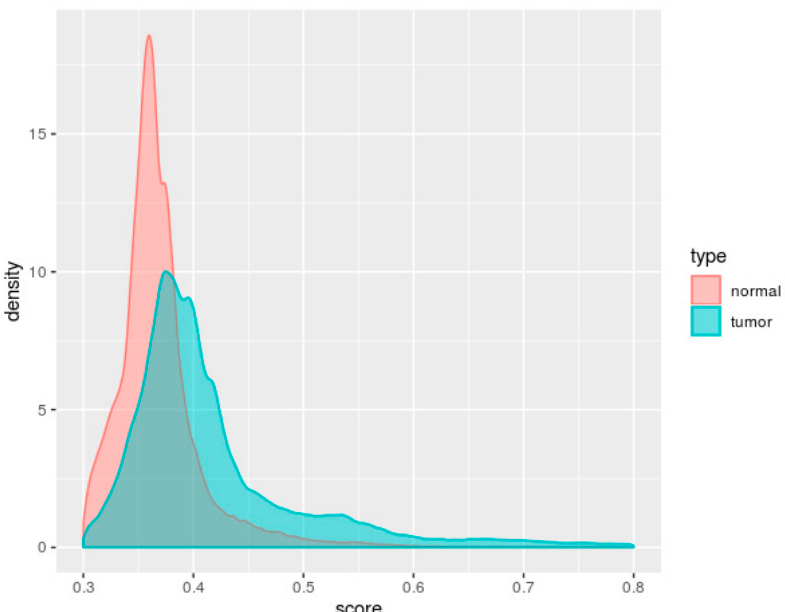
Figure 2. Density plot of the iPS score. The red and green colors represent normal samples and tumor samples, respectively. The iPSs of tumor samples are higher than those of normal samples. Additionally, the tumor samples’ iPSs are more dispersed than those of the normal samples.